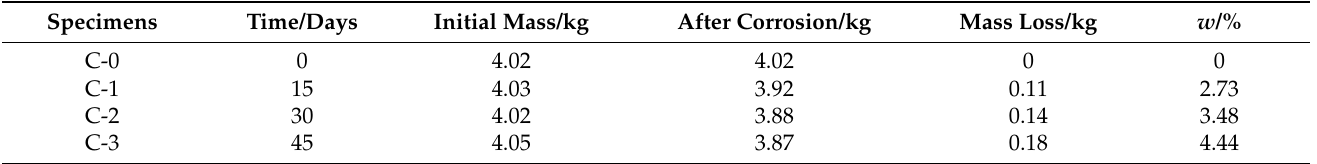
Table 4. Results of the accelerated corrosion of the bolt-sphere connections.